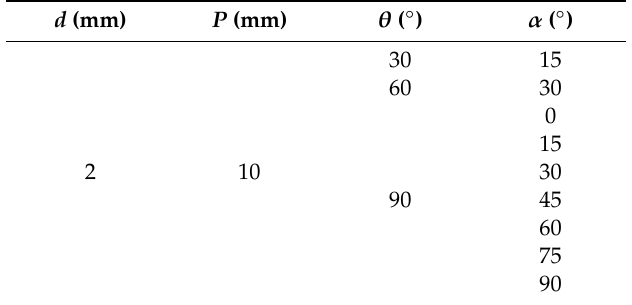
Figure 1. Sketch of a generic overlapped spacer with the main geometric parameters. The red arrow indicates the flow direction. Table 1. Investigated values of geometric parameters of spacers.